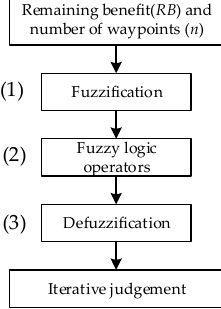
Figure 4. Schematic diagram of the FL method